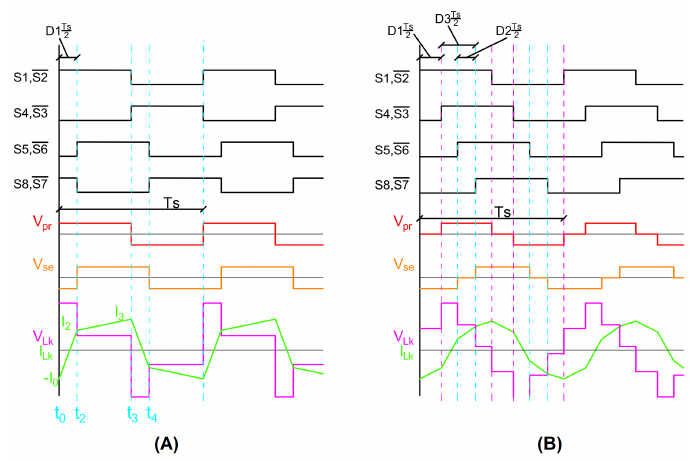
Figure 9. Standard waveforms for SPS ( A ) and TPS ( B )